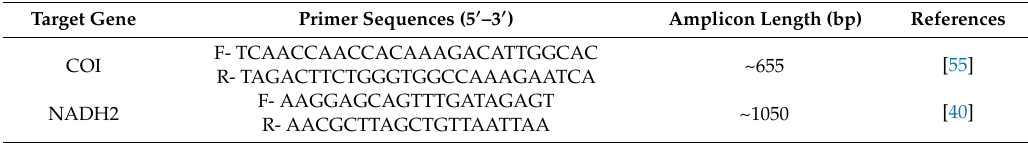
Table 1. Oligonucleotide primers—target genes.